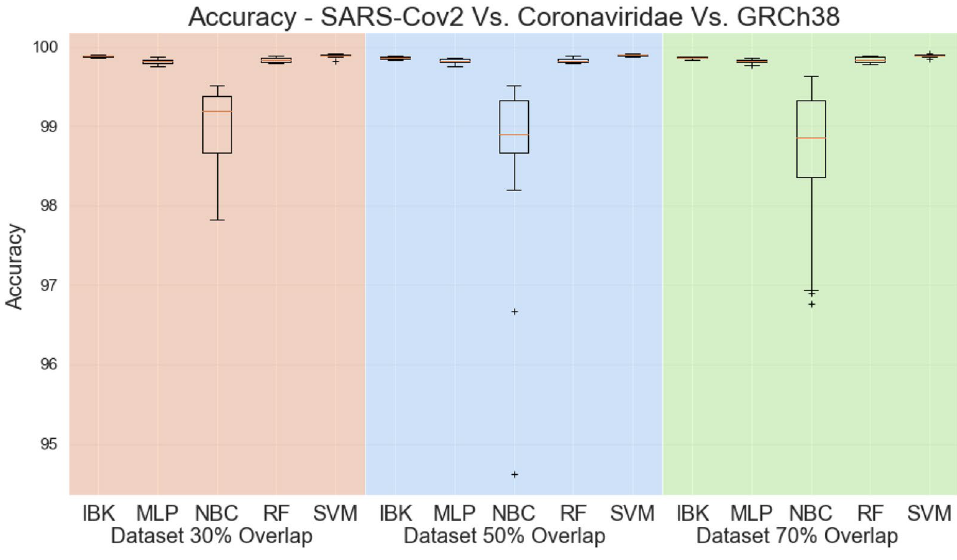
Figure 16. Accuracy for SARS-CoV-2 test scenario.